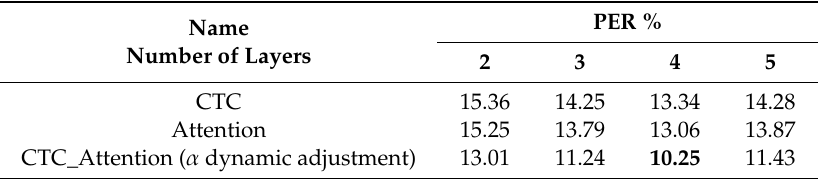
Table 7. Performance of ASR systems when the number of layers in their bidirectional long short-term memory projection (BLSTMP) encoders is di ff erent.